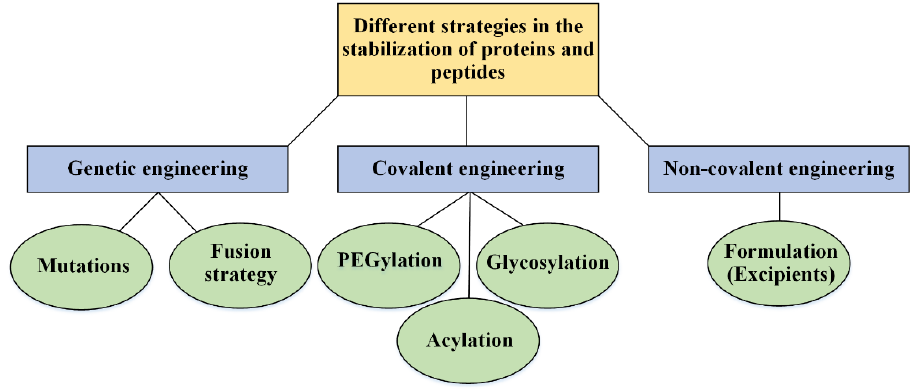
Figure 6. A variety of strategies to increase the stability of medicinal proteins and